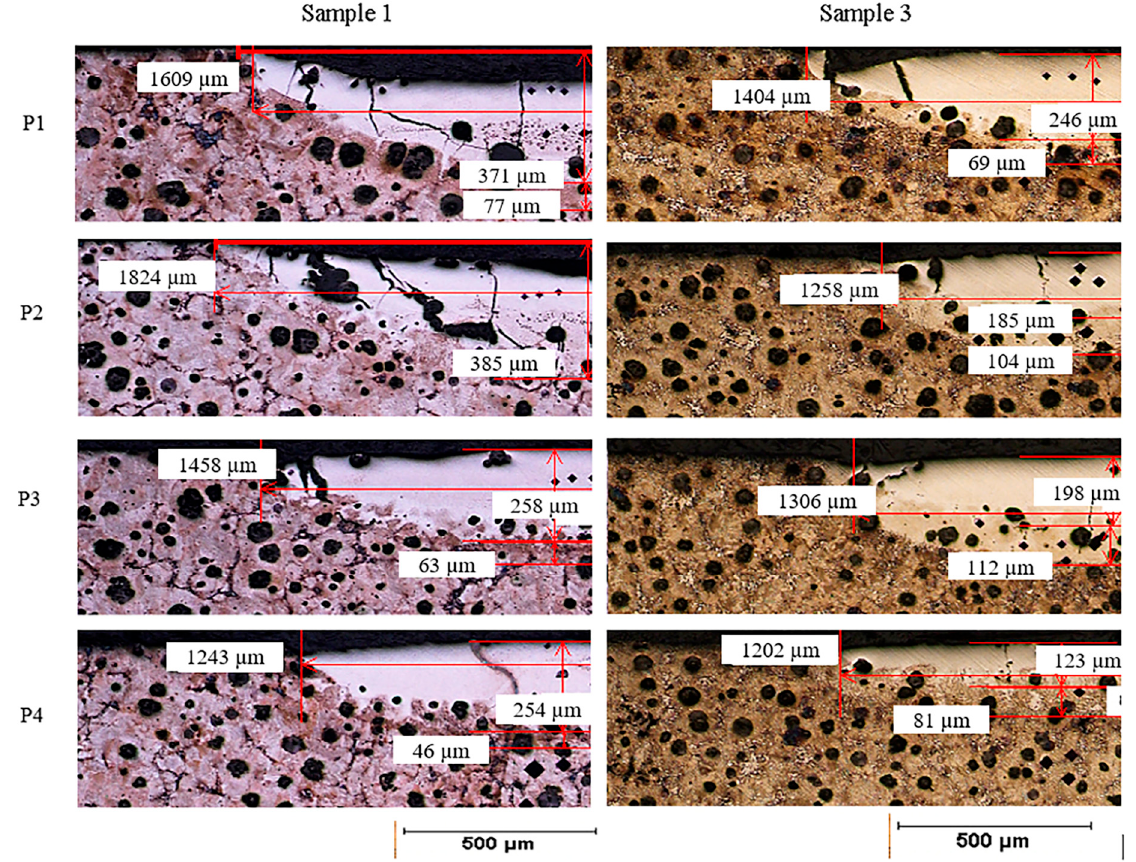
Figure 5. Seams dimensions of DI: Sample 1 (S1) and ADI: Sample 3 (S3), with 0.2 mm/s